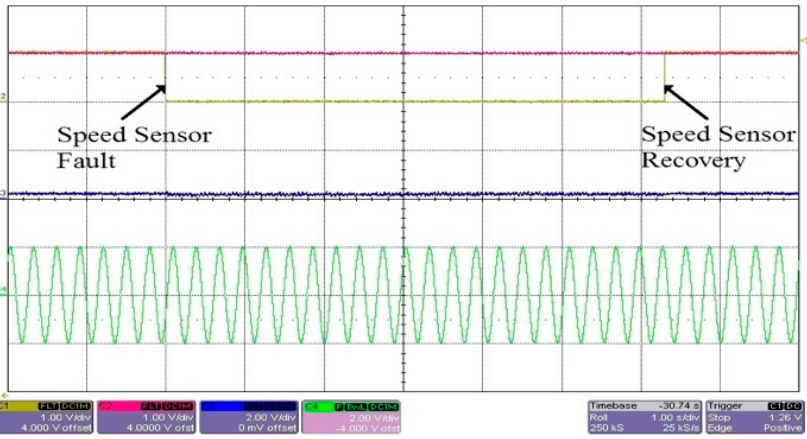
Figure 7. Experimental result: rotor speed sensor fails and recovers—steady state at 100 rpm, no load. Measured (yellow) and estimated (red) rotor speed, torque producing stator current (blue) and a-phase stator current (green). Scales: speeds—100 rpm/div; currents—2 A/div; time—1 s/div.